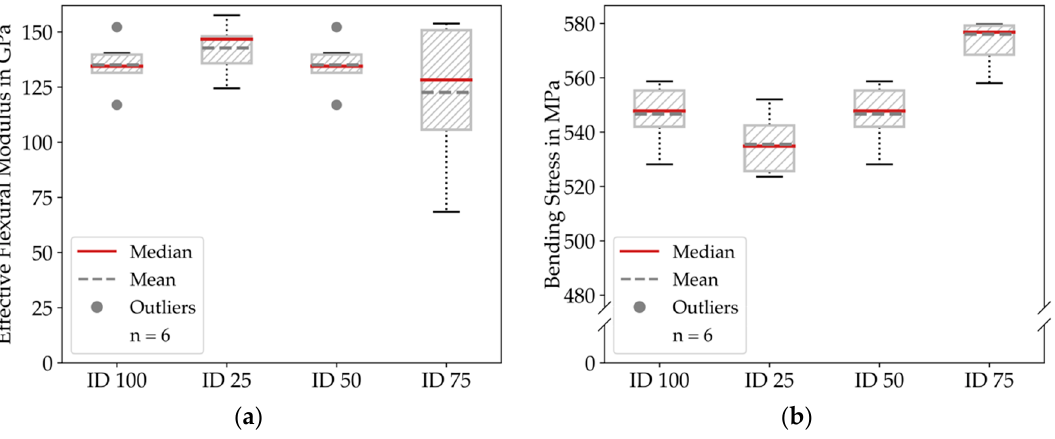
Figure 14. Results of the bending testing experiments clustered by infill degree: ( a ) Effective flexural modulus for all configurations; ( b ) Bending stress for all configurations. The flexural modulus is quasi constant for all infill